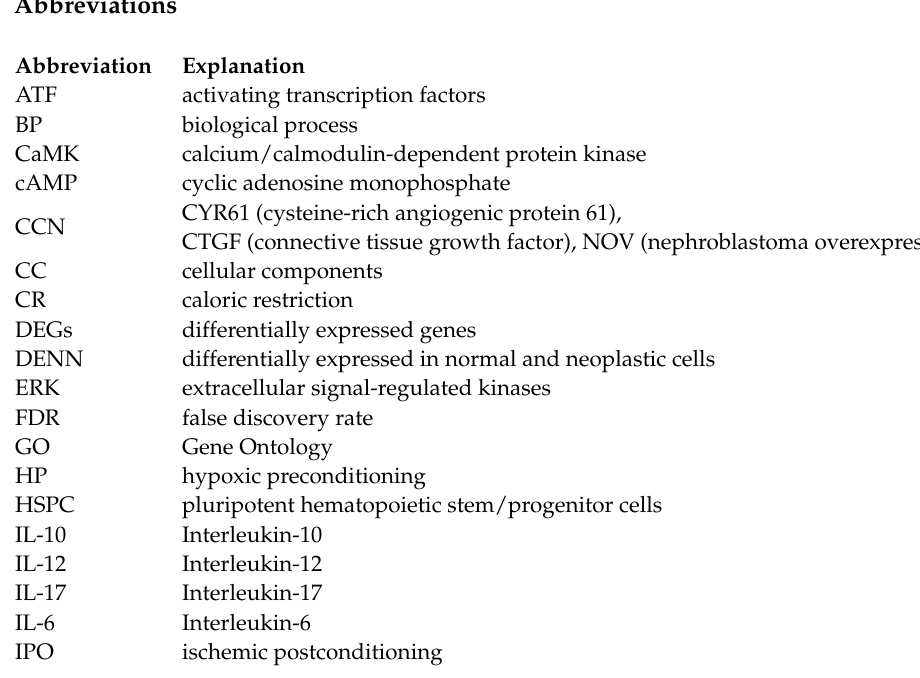
Table S9: The list of enriched GO terms in Biological processes domain for Downregulated genes, Table S10: The list of enriched GO terms in Cellular Component domain for Downregulated genes, Table S11: The list of enriched GO terms in Molecular Function domain for Downregulated genes, Table S12: The list of enriched KEGG pathways for Upregulated genes, Table S13: The list of enriched KEGG pathways for Downregulated